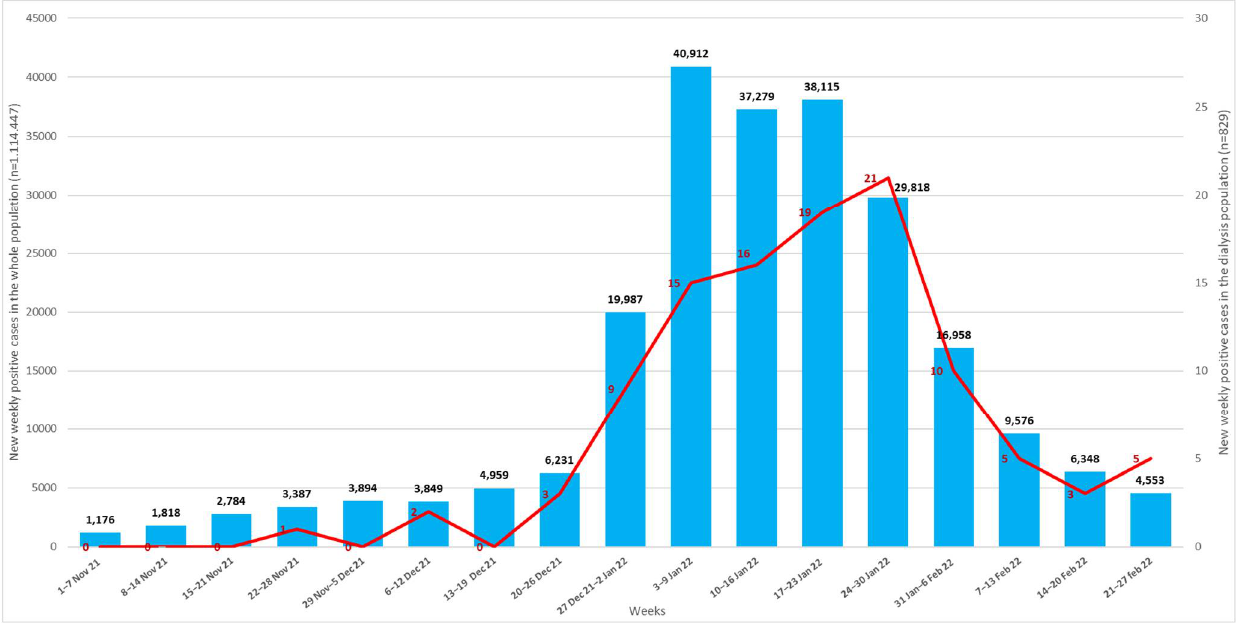
Figure 2. Weekly confirmed COVID-19 new cases from 1 November 2021 to 28 February 2022 in the general population (blue bars) and in dialysis patients (red line) of Romagna territory.